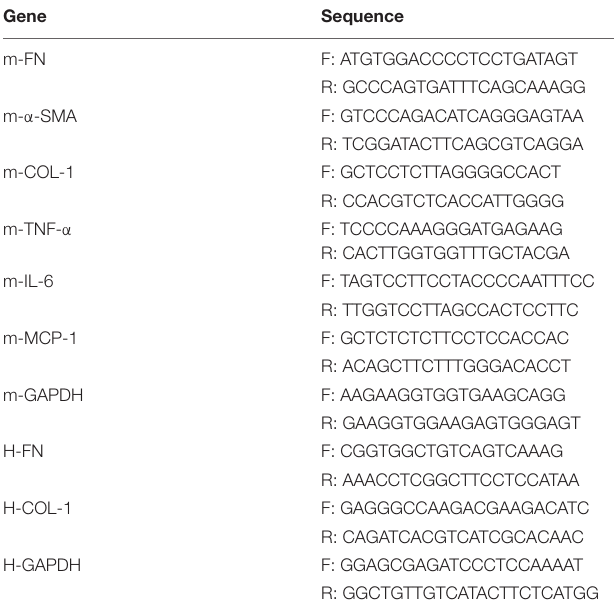
TABLE 1 | Primer sequences for quantitative real-time-PCR (qRT-PCR). Gene